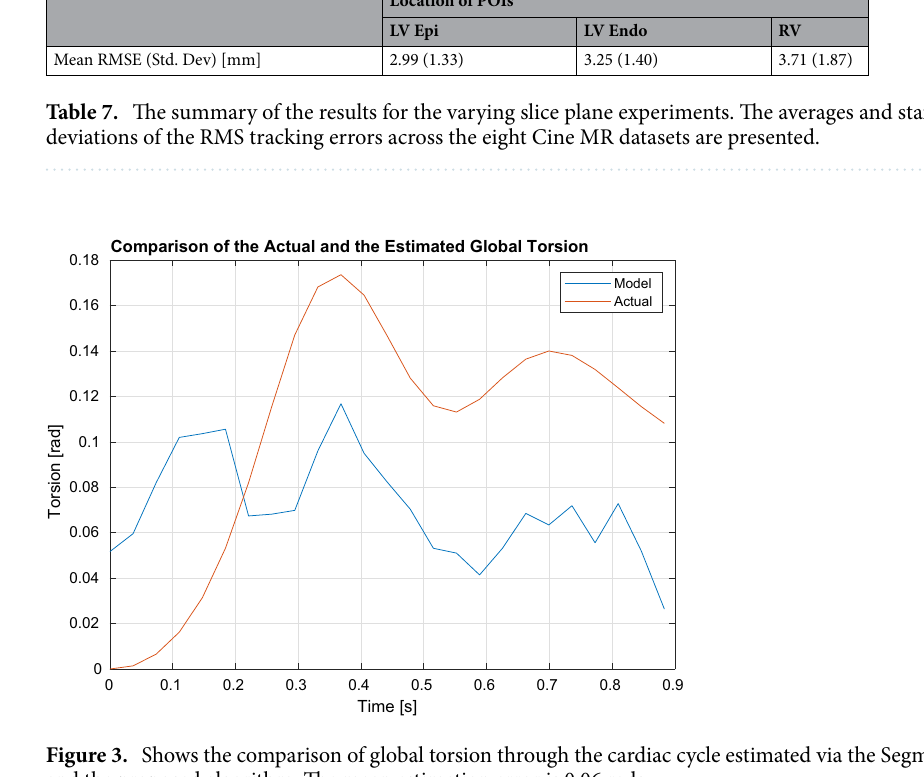
Figure 3. Shows the comparison of global torsion through the cardiac cycle estimated via the Segment software and the proposed algorithm. The mean estimation error is 0.06